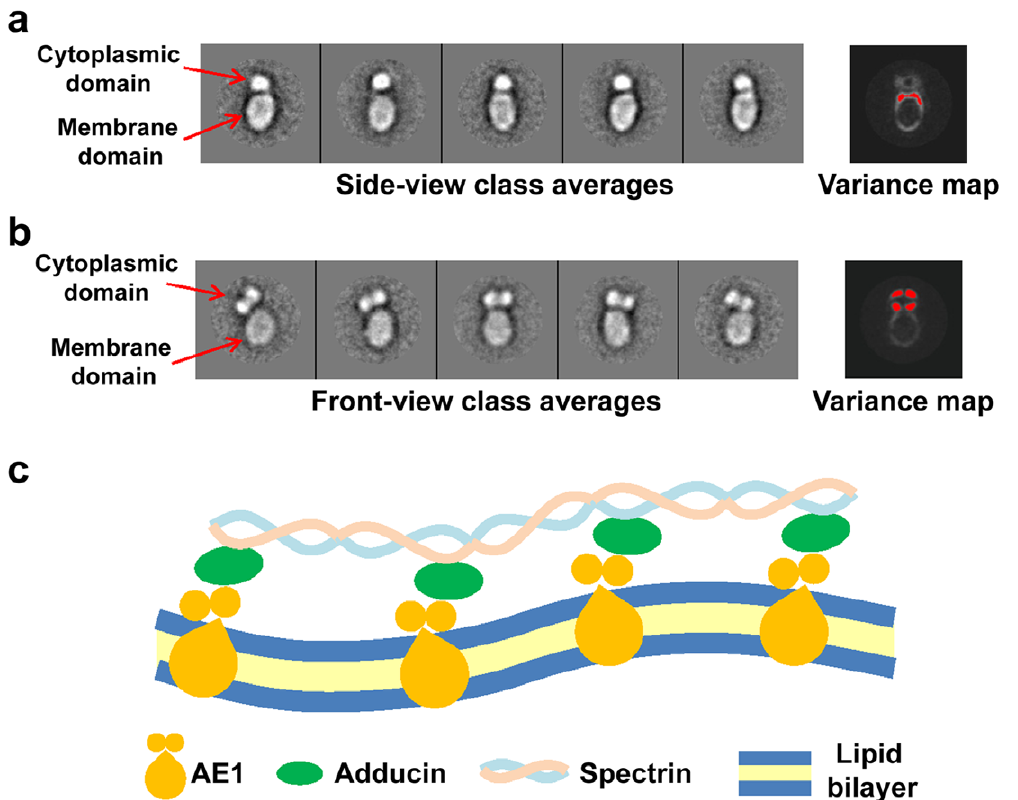
Figure 5. Flexibility of AE1. ( a,b ) Representative class averages and variance maps of the side-view particles ( a ) and the front-view particles ( b ). In the variance maps, the white areas indicate high variance and the areas with statistical significance ( . 4 s ) are highlighted with red color. Note that relative orientation of the projection density corresponding to cytoplasmic domain to that of membrane domain remains uniform in ( a ) but varies in ( b ), suggesting flexibility of the connecting linkers in the sideward direction. The variance maps in ( a ) and ( b ) were calculated from 24 and 58 class averages, respectively. The side length of boxes in ( a ) and ( b ) is 34 nm. ( c ) Mechanistic diagram illustrating AE1 association with the cytoskeleton and how its connector flexibility contributes to erythrocyte shape control. The tilting of the cytoplasmic domain is induced when the erythrocyte membrane is deformed. The connector acts as a pivot between the cytoplasmic and the membrane domains.